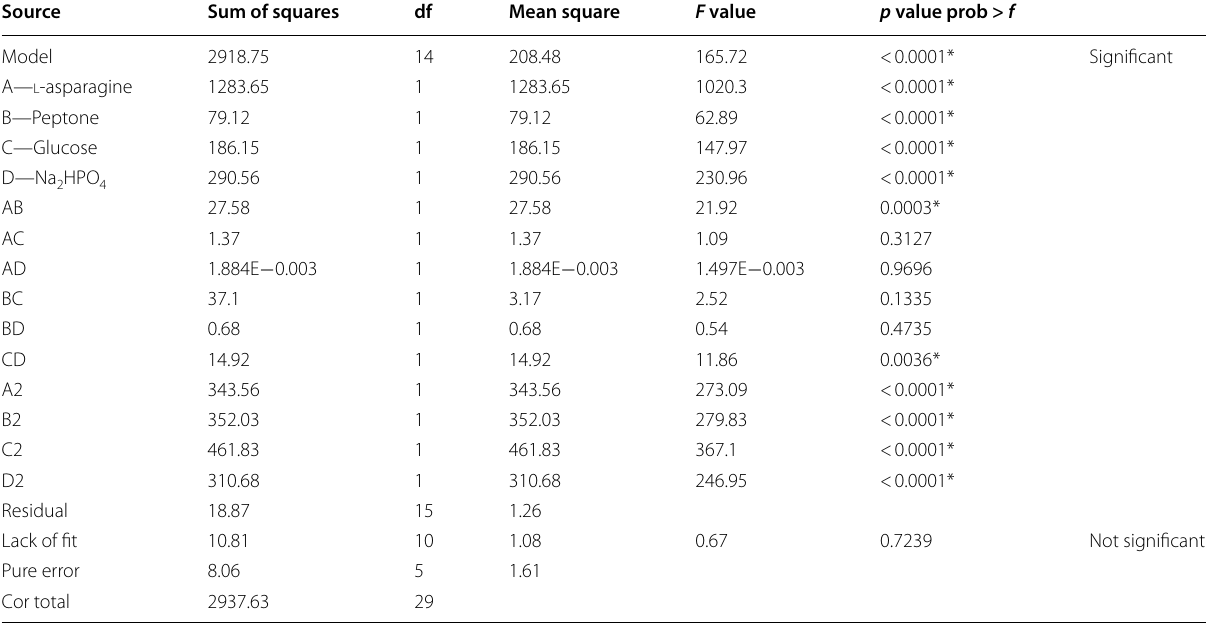
*Statistically significant at 95% confidence level ( p value <